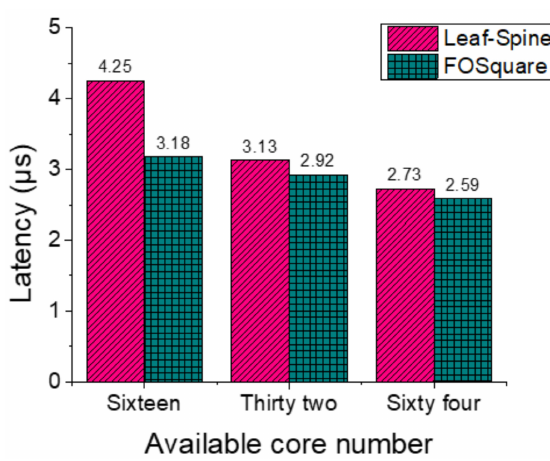
Figure 8. MILC application